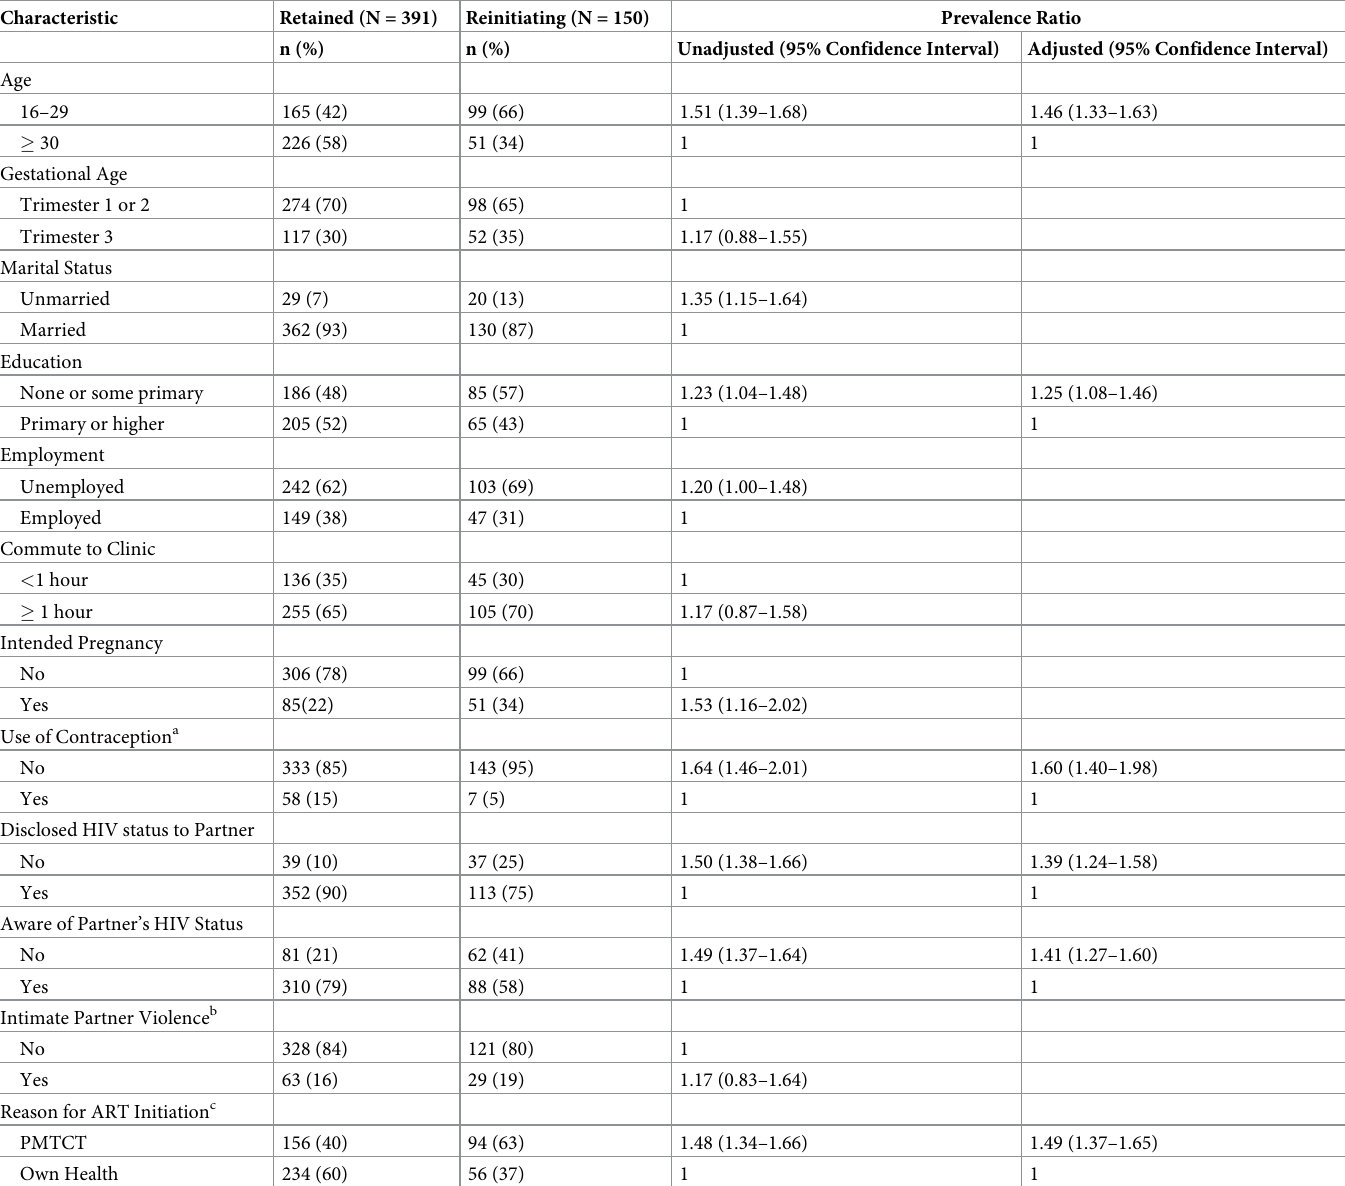
Table 2. Factors associated with ART interruption among Malawian women presenting for antenatal care.